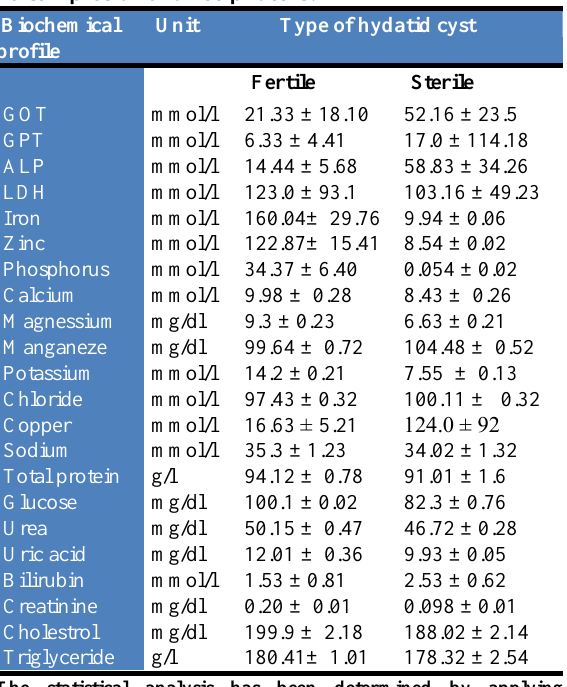
Table, 1: Biochemical components (mean±SE) of fertile and sterile hydatid cyst fluid values given of 10 samples of two reciprocals.